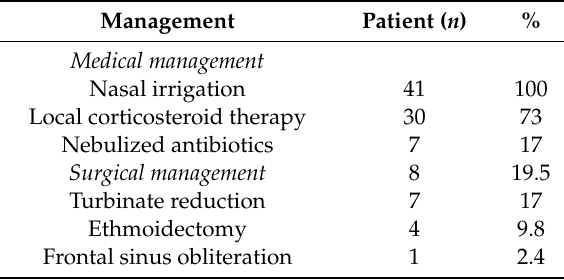
Table 4. Medical and surgical management of PCD adults ( n = 41) in our